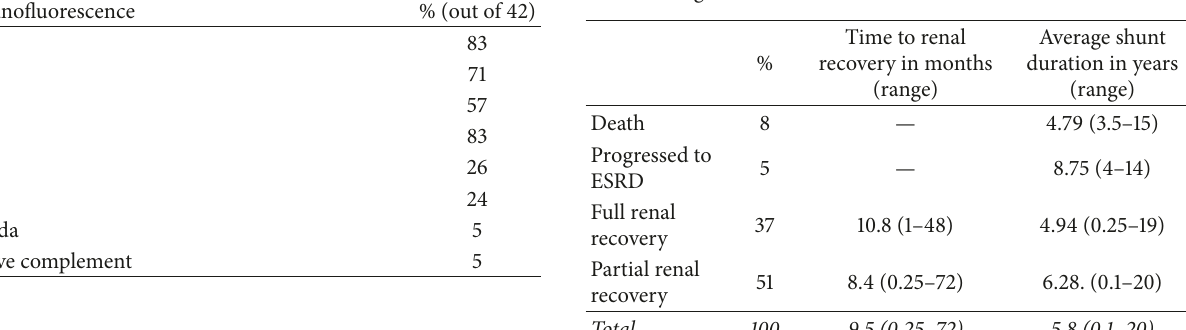
Table 8: Time to renal recovery after shunt nephritis treatment versus average shunt duration.